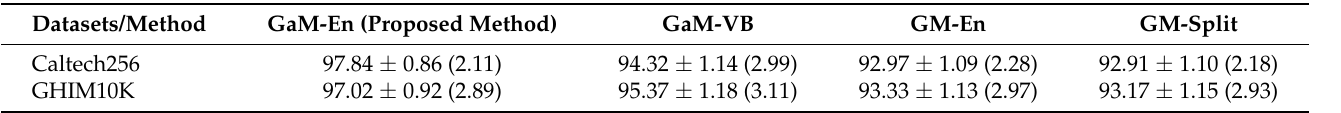
Table 3. Results of object categorization using different models (average % ± standard error (Average time